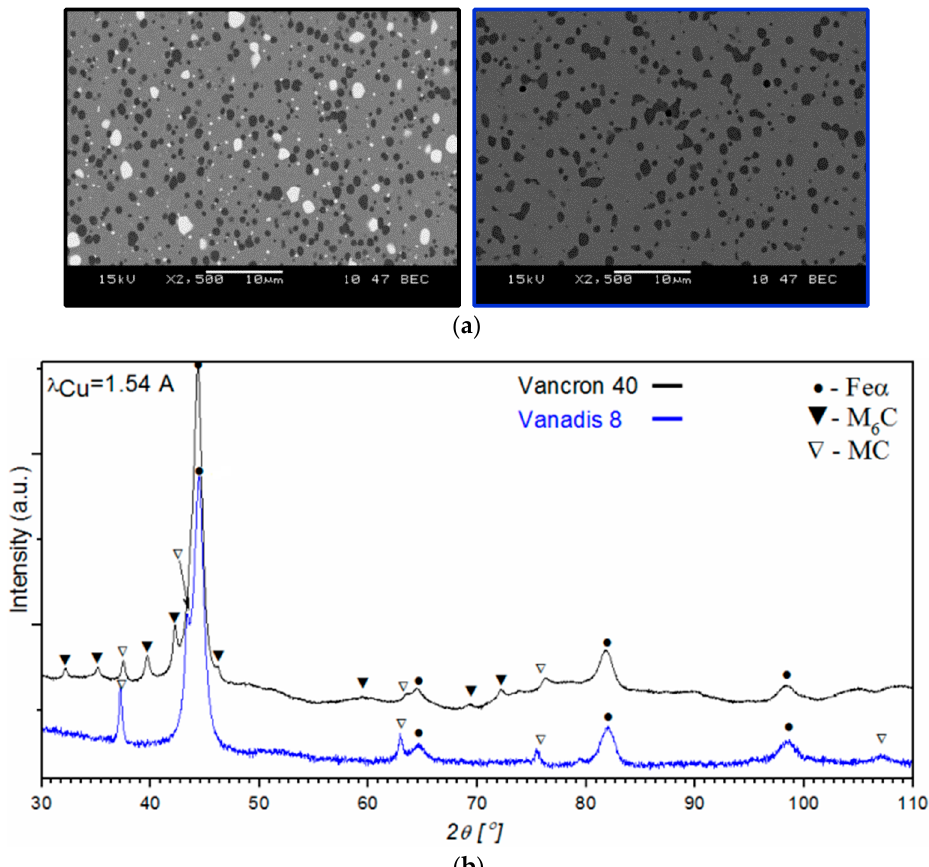
Figure 3. Cross-sectional micrographs ( a ) and results of X-ray diffraction analysis ( b ) for Vancron 40 and Vanadis 8 steels after heat treatment.